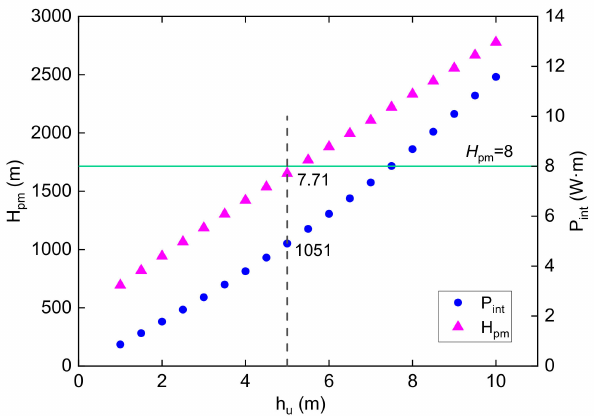
Figure 9. Simplified algorithm that can be used to select the optimal height combination ( h u , h d ) when h d = 7 m.